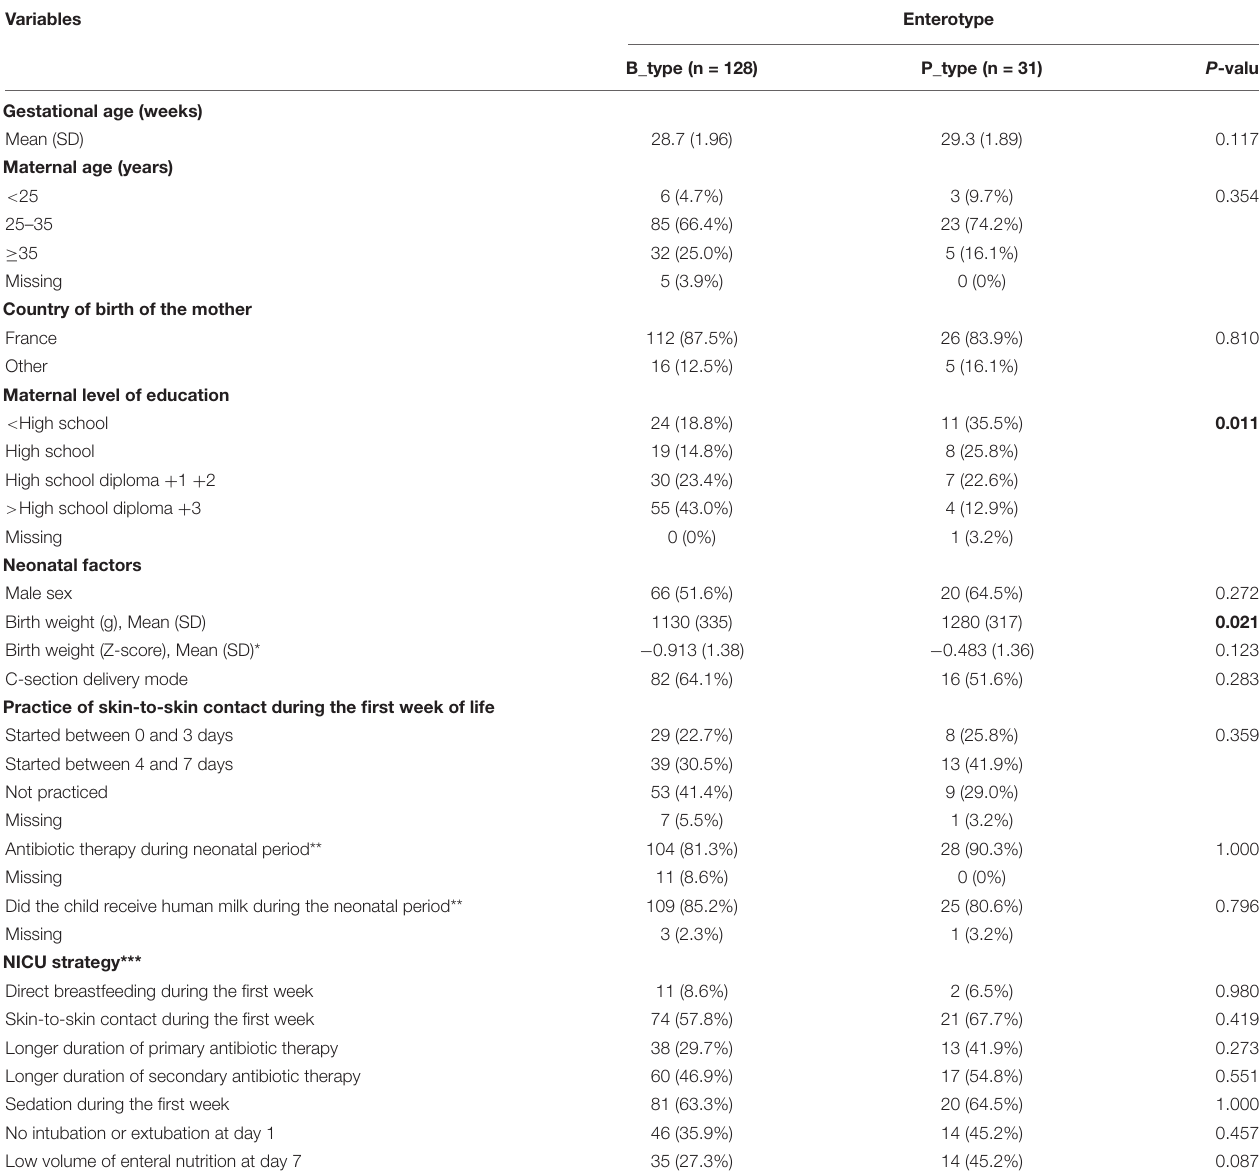
TABLE 1 | Univariate association between preterm children enterotypes at 3.5 years of age, neonatal characteristics, and NICU strategies.